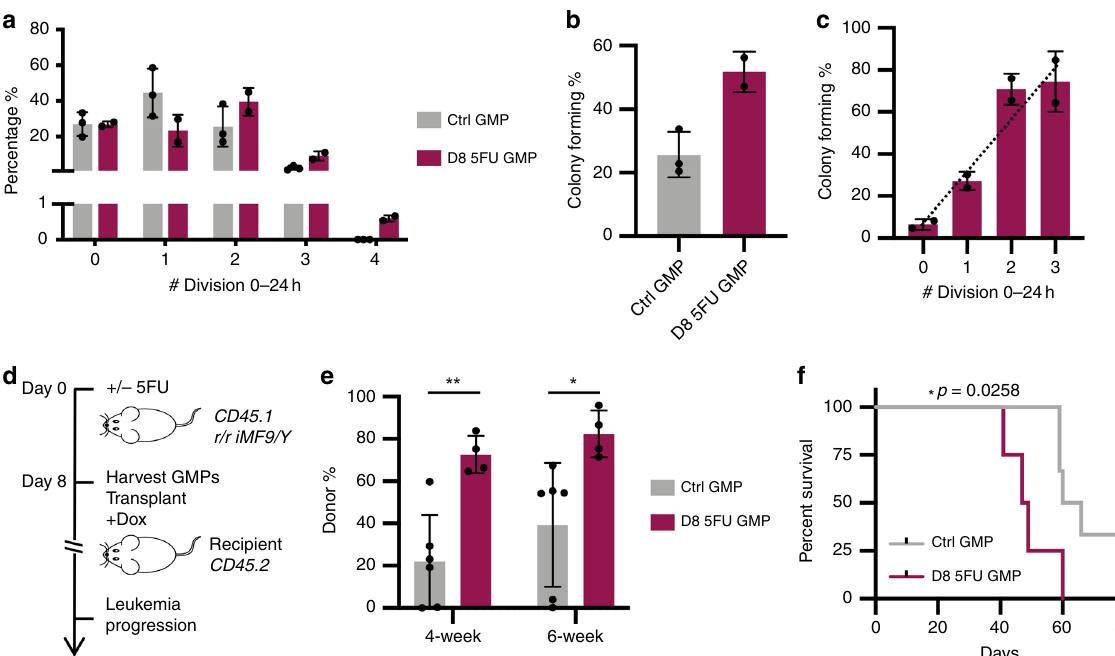
Fig. 7 Activated GMPs during emergency myelopoiesis support more ef fi cient transformation. a Cell cycle rate distributions of steady-state control GMPs or 5FU-activated GMPs; n = 3 for Ctrl GMP, n = 2 for D8 5FU GMP. b Single-cell colony-forming ef fi ciencies from steady-state control iMLL-AF9 GMPs or 5FU-activated iMLL-AF9 GMPs; n = 3 for Ctrl GMP, n = 2 for D8 5FU GMP. c Colony-forming ef fi ciencies by 5FU-activated iMLL-AF9 GMPs of different cell cycle rates; n = 2, dotted line represents linear regression, y = 24.73 × + 7.649, p = 0.0006 by F -test. d Schematics showing leukemogenesis by steady-state control iMLL-AF9 GMPs or 5FU-activated iMLL-AF9 GMPs. e Donor-derived (CD45.1 + ) nucleated cell percentages in peripheral blood of recipient mice at 4- or 6-weeks after transplantation; n = 6 for Ctrl GMP, n = 4 for D8 5FU GMP, p = 0.0027 for 4 weeks, p = 0.0243 for 6 weeks, as calculated by unpaired t -test. f Kaplan – Meier curve of the cohorts injected with steady-state control iMLL-AF9 GMPs or 5FU-activated iMLL-AF9 GMPs; n = 6 for Ctrl GMP, n = 4 for D8 5FU GMP, p = 0.0258 as calculated by Log-rank (Mantel – Cox) test. Results are presented as